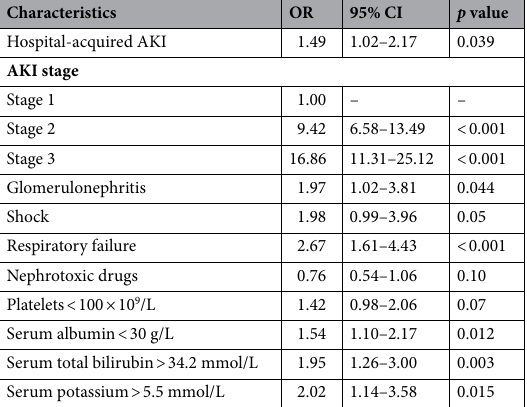
Table 3. Multivariable logistic regression analysis of risk factors associated with MAKE30. OR odds ratio, CI confidence interval, AKI acute kidney injury.